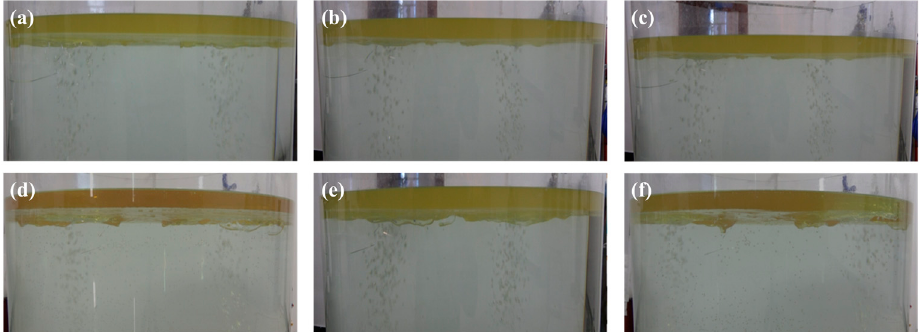
Figure 12. Slag entrapment behavior of double-hole 2, 11, 1, 11 and 6, 12 at 2.5 L/min ( a – c ), 3.8 L/min ( d – f ) bottom blowing flow.